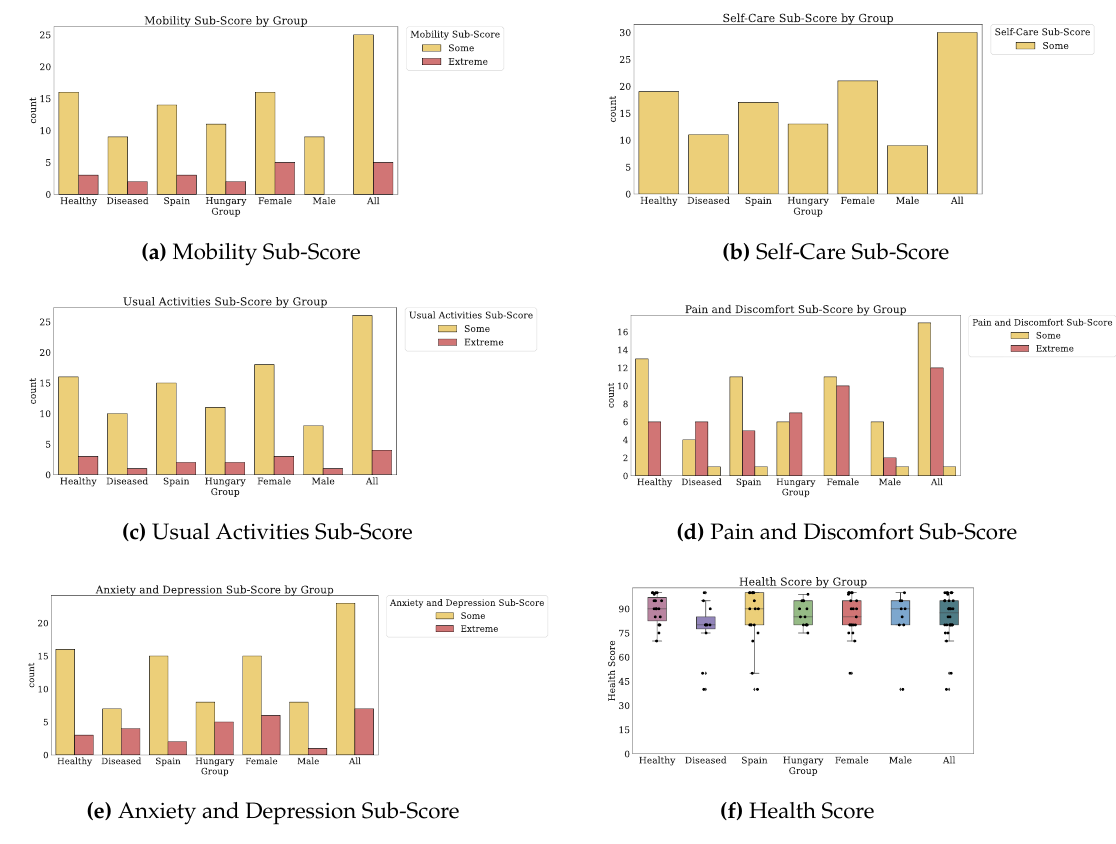
Figure A10. Sub-scores and Scores for Health-Related Quality of Life (EQ-5D-3L). The mean SD perceived health is at 84.96 ±